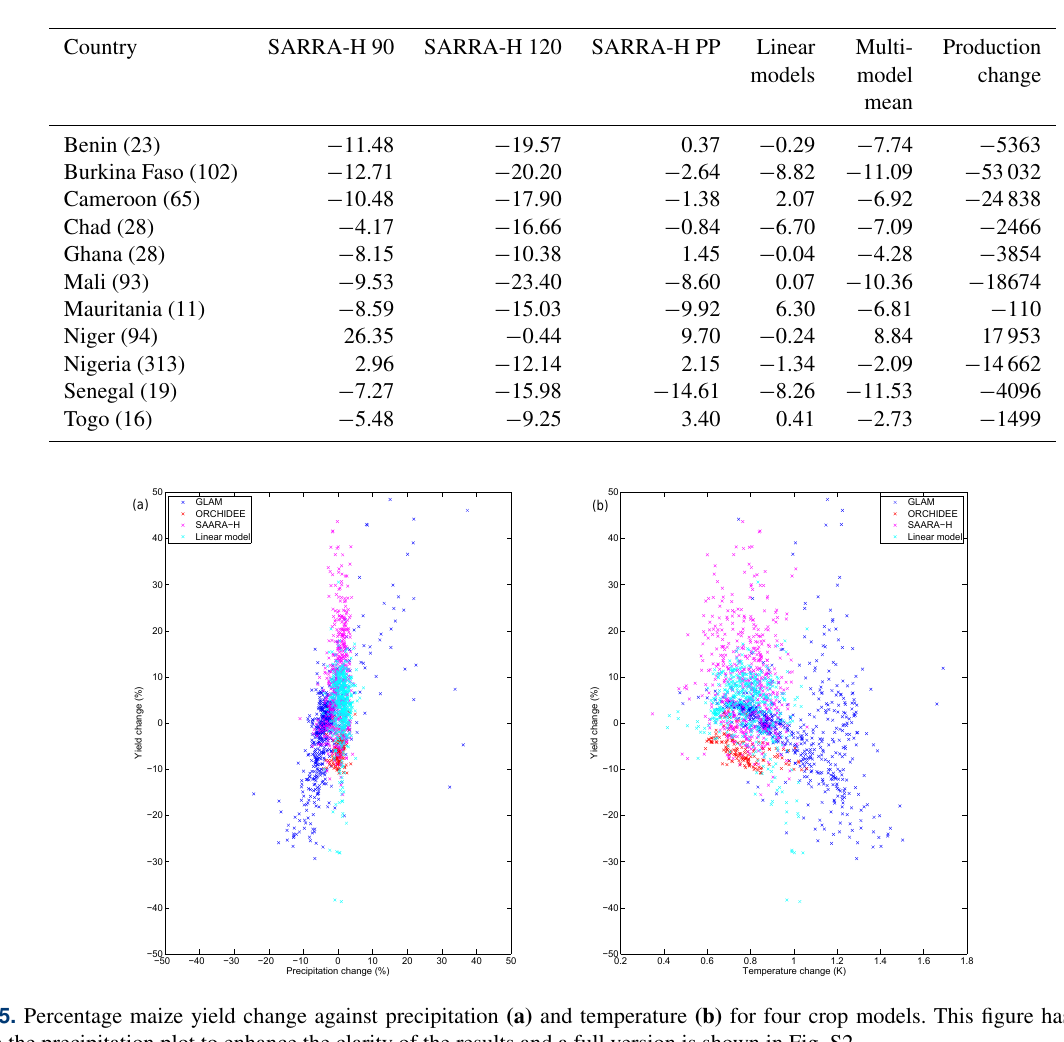
Table 8. Percentage sorghum yield change by country. The number of grid cell analysed is in brackets and countries where fewer than 10 grid cells were analysed have been omitted. The production change is shown in the rightmost column in tonnes.